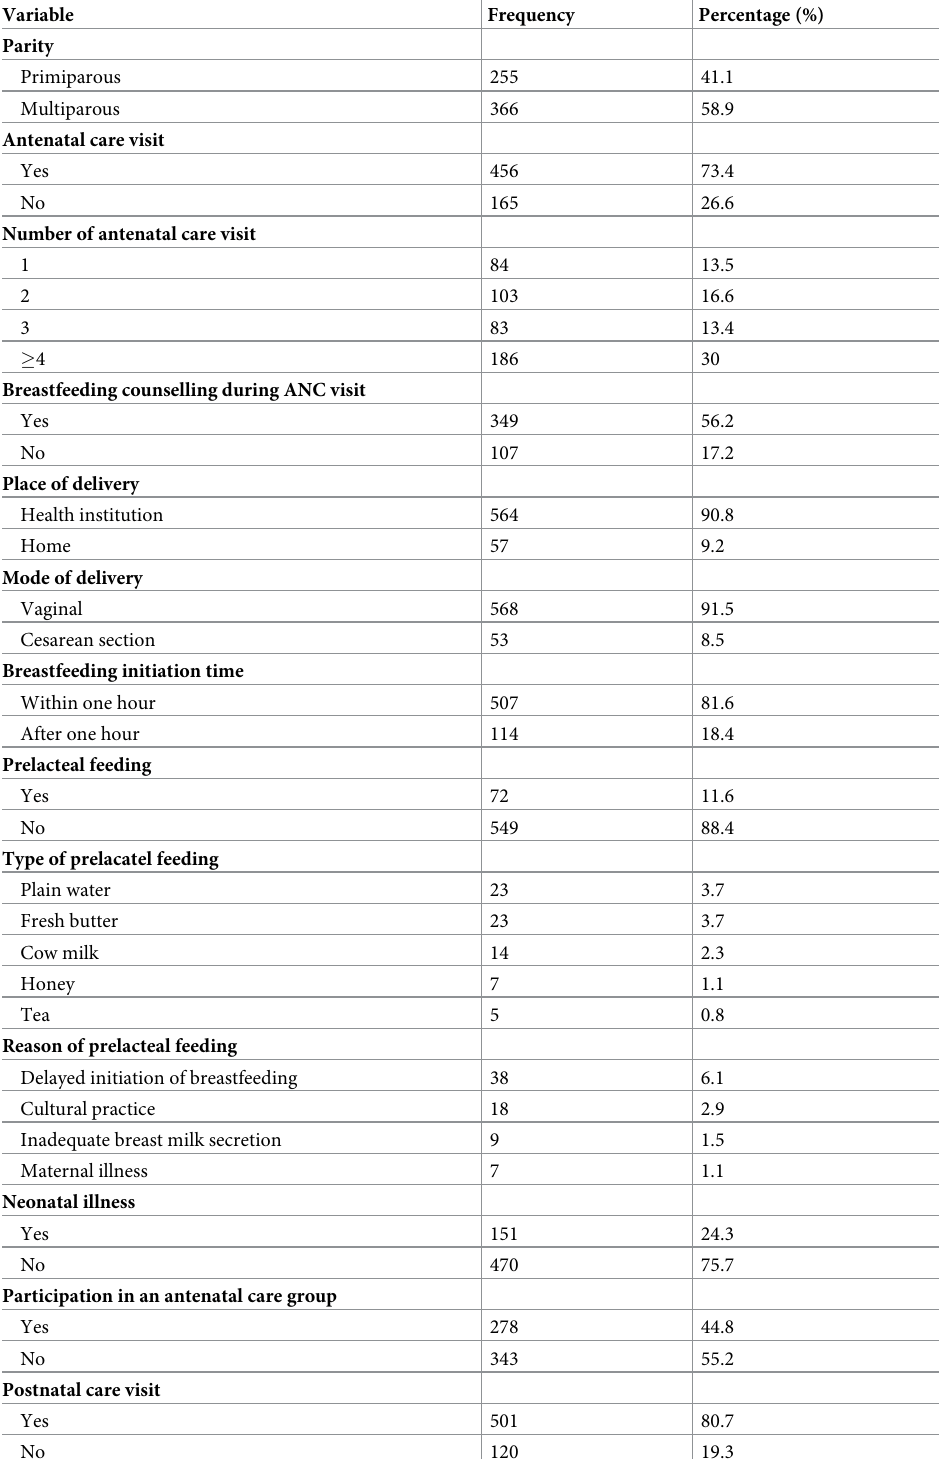
Table 2. Maternal health care service utilization among mothers of children aged less than six months in Bure District, Amhara Region, North West, Ethiopia, 2019 (n =